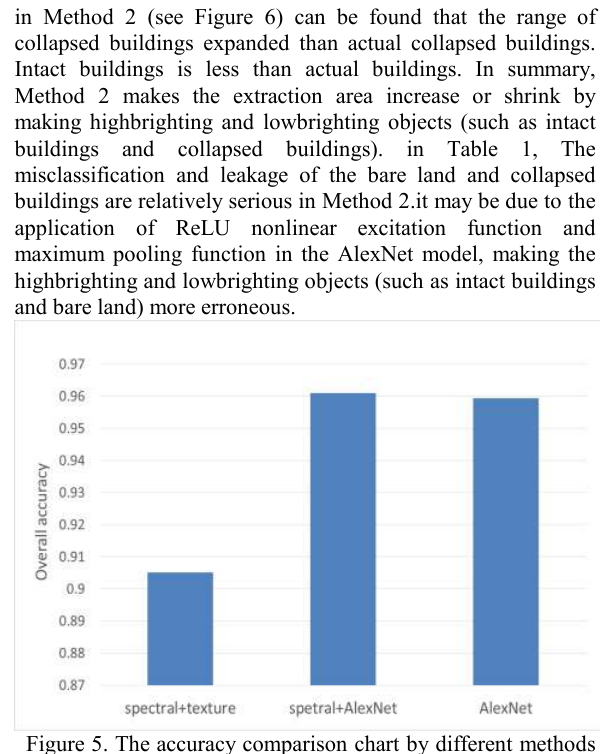
Figure 3. The classification accuracy comparison chart with deep feature layers